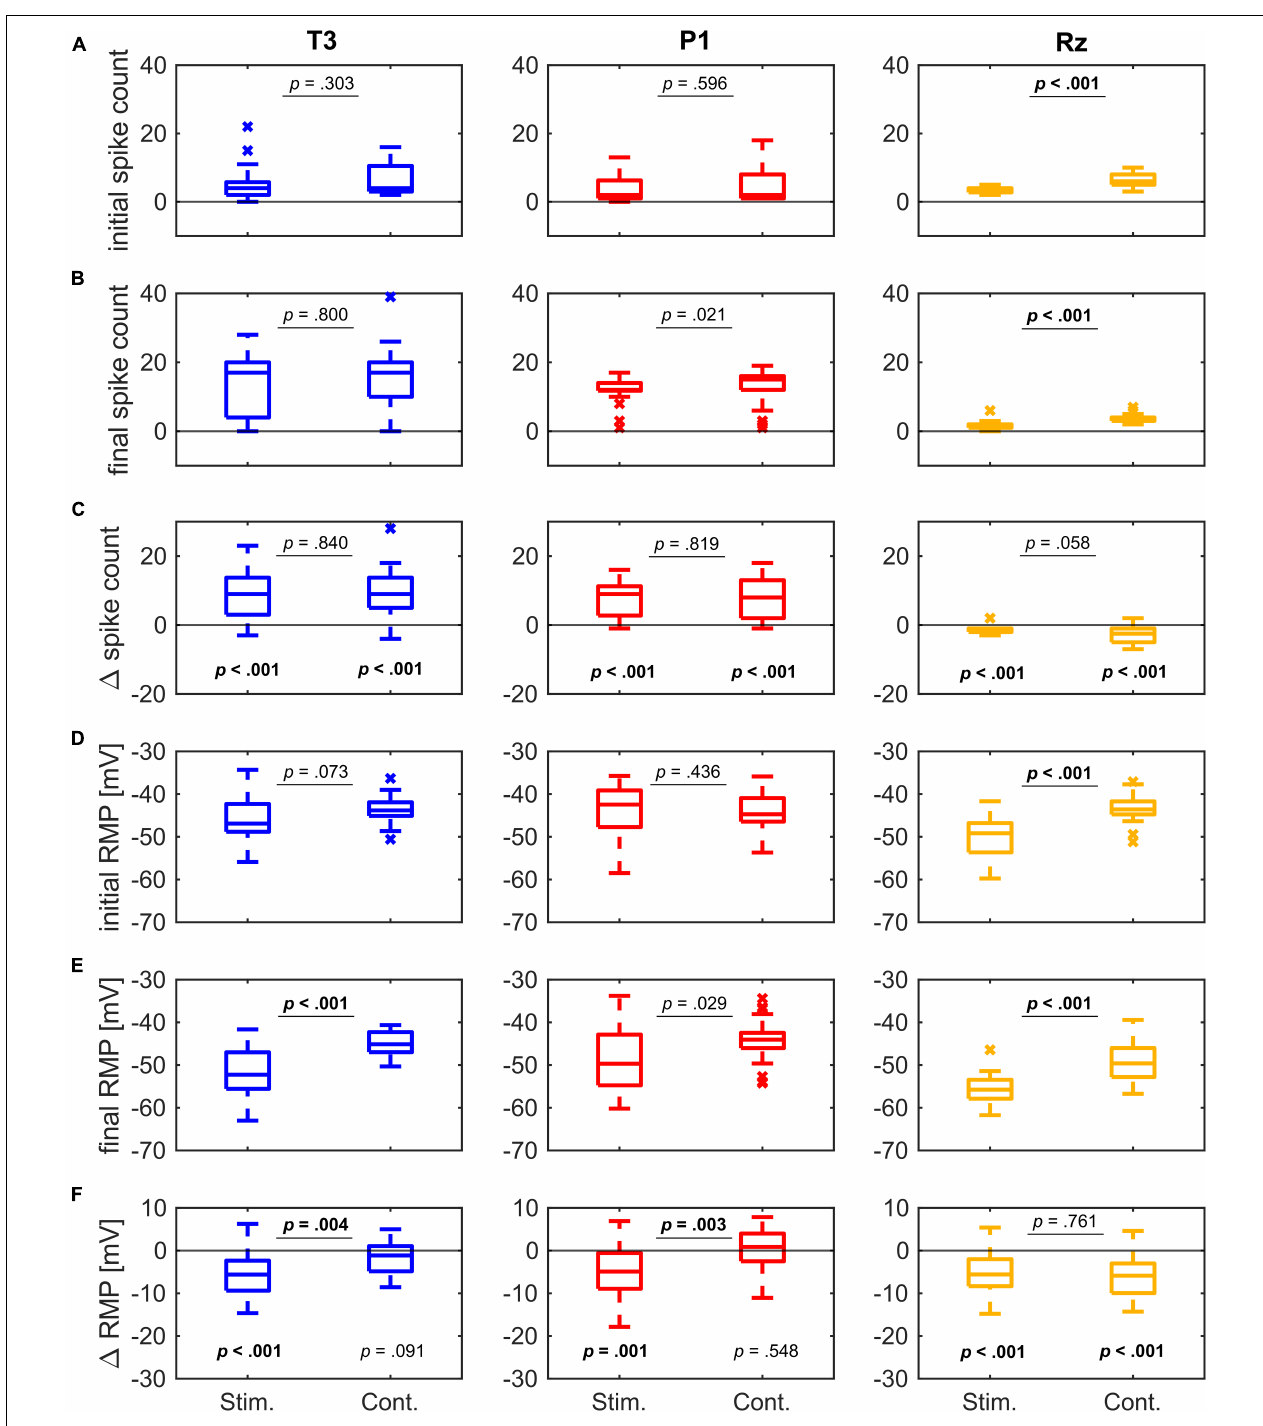
FIGURE 6 | Spike count and RMP comparison between the stimulation protocol (Stim.) and the control protocol (Cont.) for all three cell types. Statistical test decisions are based on the Wilcoxon test. Multiple testing was accounted for by Bonferroni adjustment of the significance level from α < 0.05 to α ’ < 0.01. Significant results are marked in bold . (A) The initial spike count did not differ between the two protocols for T3 and P1 cells. In Rz cells, the spike count was significantly higher in the control protocol. (B) The final spike count after 10 min did not differ between the two protocols in T3 and P1 cells, but in Rz cells. (C) The (cid:49) spike count differed significantly from zero for all cell types and both protocols. T3 and P1 cells increased their spike count over time, irrespective of the protocol. Rz